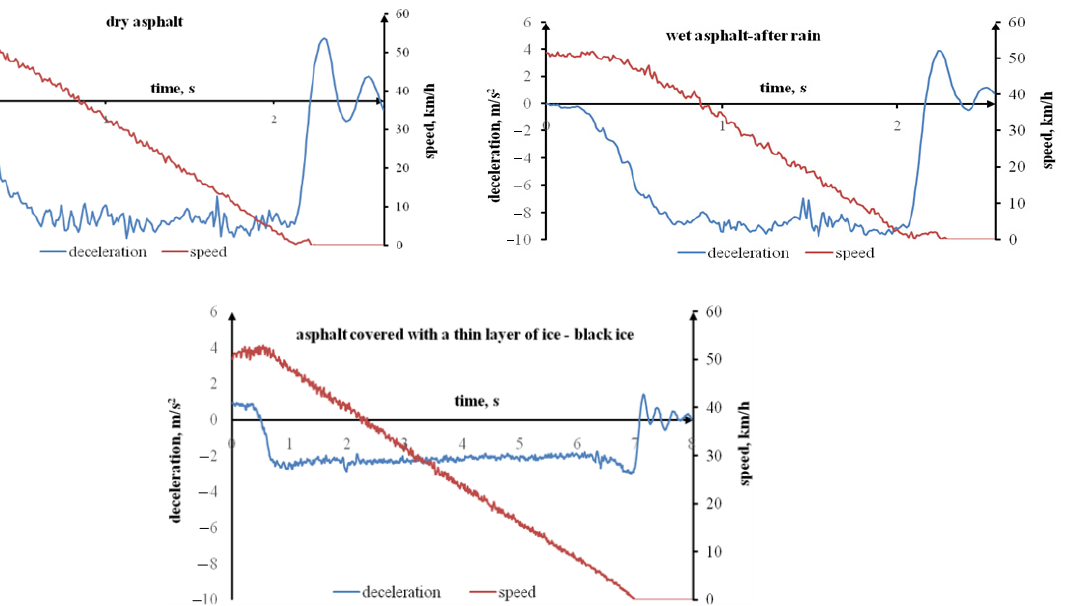
Figure 3. Examples of the Ford Transit’s deceleration and speed during rapid braking on a dry surface, a wet (after rain) asphalt surface, and a surface covered with a thin ice layer with the starting speed of approximately 50 km/h.